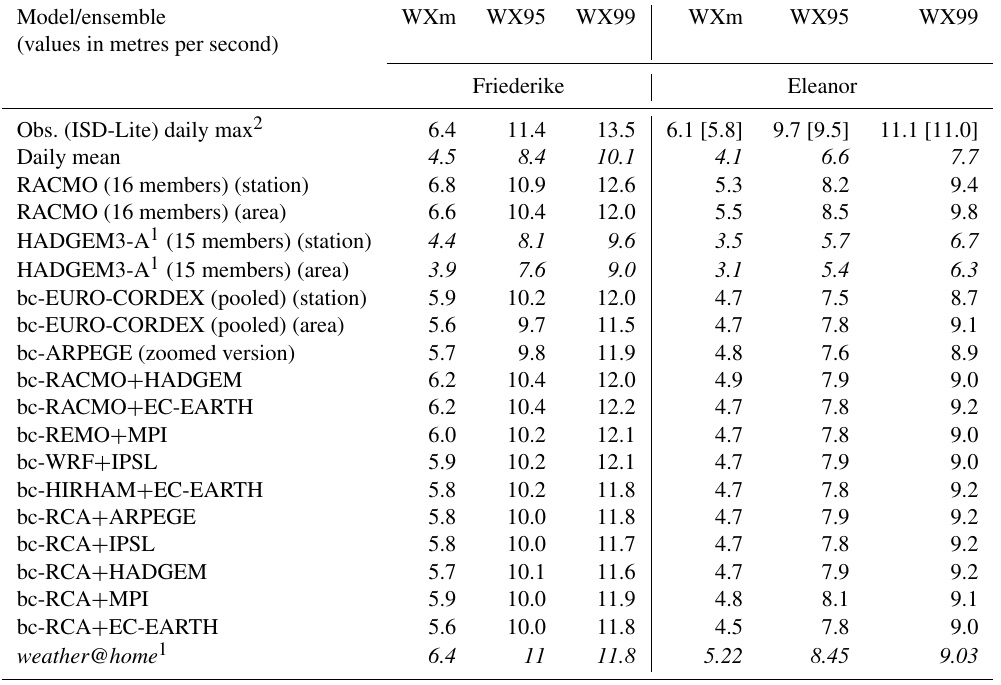
Table 1. Mean (WXm), 95th (WX95), and 99th (WX99) percentiles of the distribution of the daily maxima of wind speed averaged over the 68 stations or the land grid points (for models) for the winter season. Italics indicate that the daily mean rather than the daily maxima of the wind speed statistic has been used. Observation cells (Obs.) are the first two data rows, the upper one gives the daily maximum of the wind speed statistic, and the lower one (in italics) gives the daily mean of the wind speed statistic. For the three model ensembles (RACMO, EURO-CORDEX (pooled), and HadGEM3-A), both station (station) and area (area) averages are shown. For weather@home only the area average was